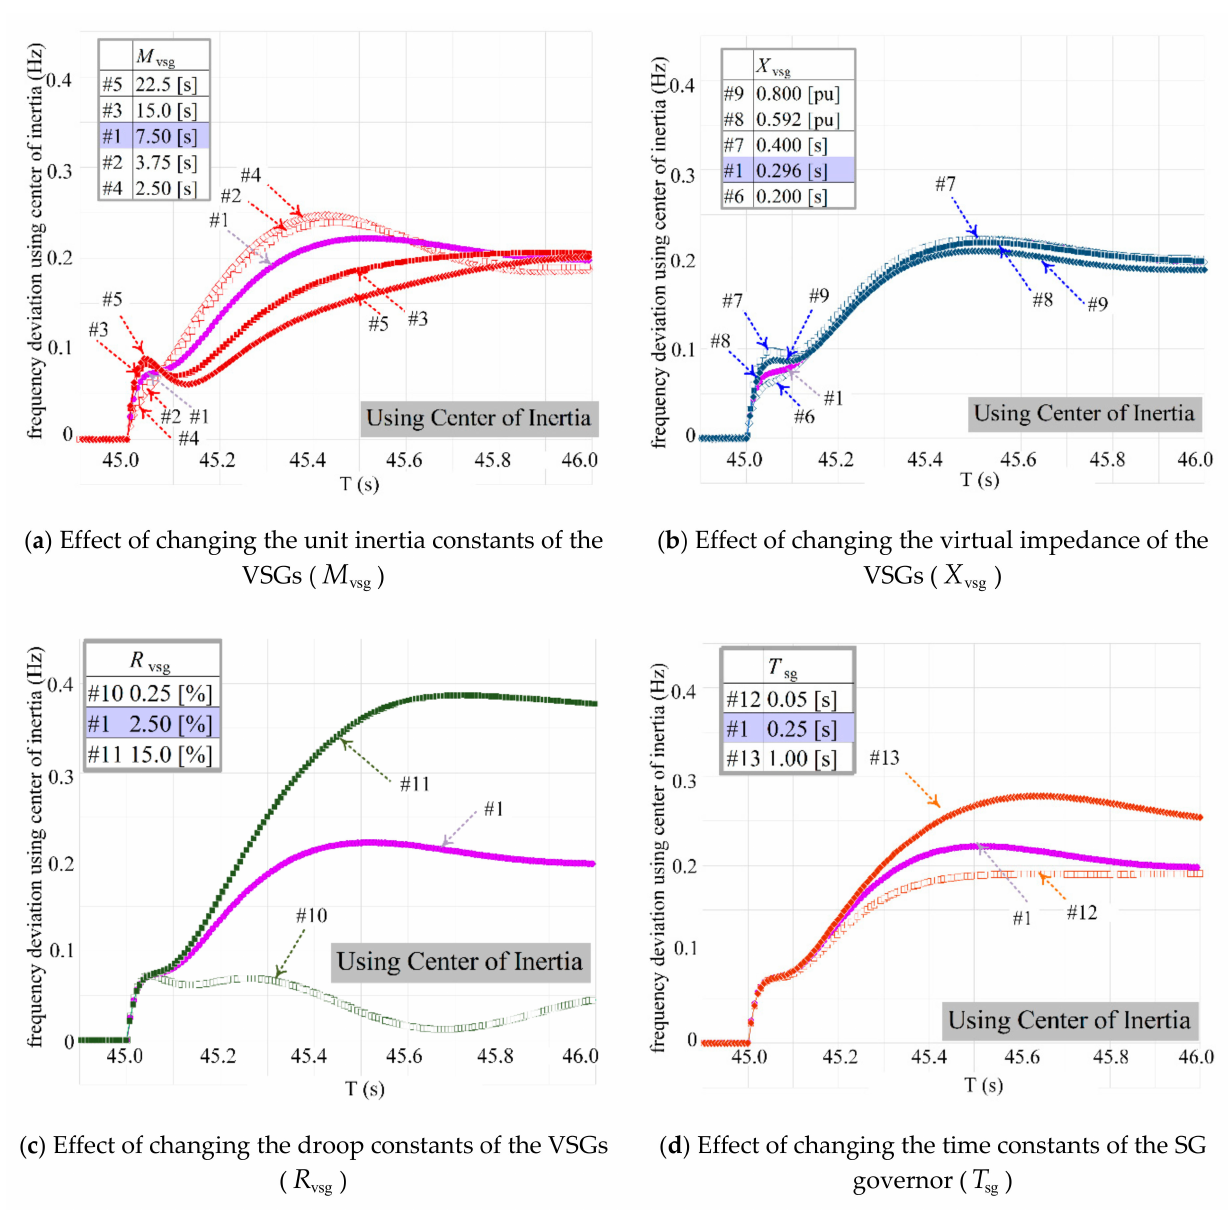
Figure 9. Comparison of the frequency deviations of the center of inertia. (Note the sign